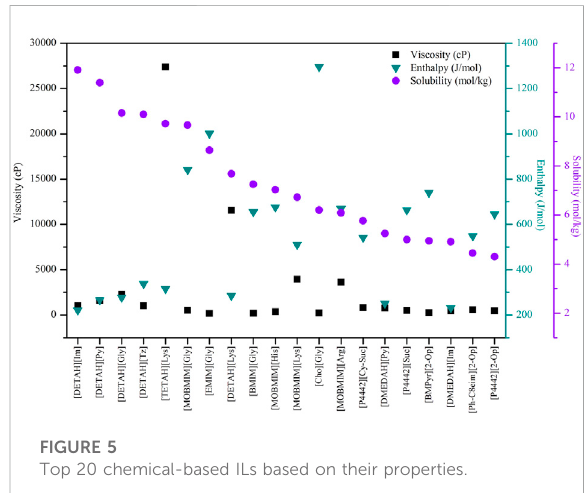
FIGURE 5 Top 20 chemical-based ILs based on their properties.